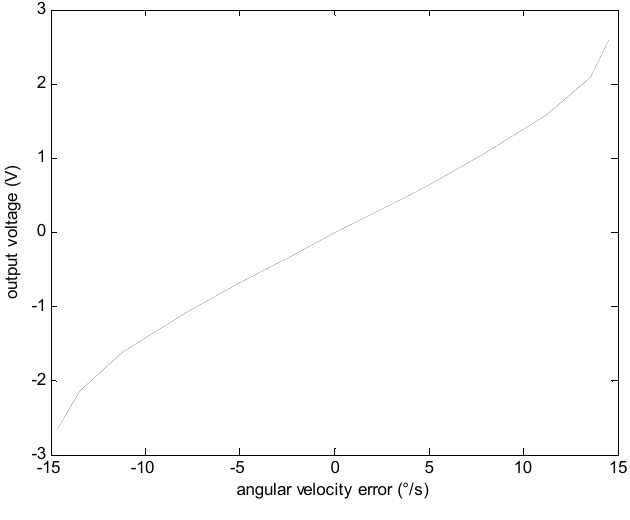
Figure 6. The relationship between output voltage and angular velocity.